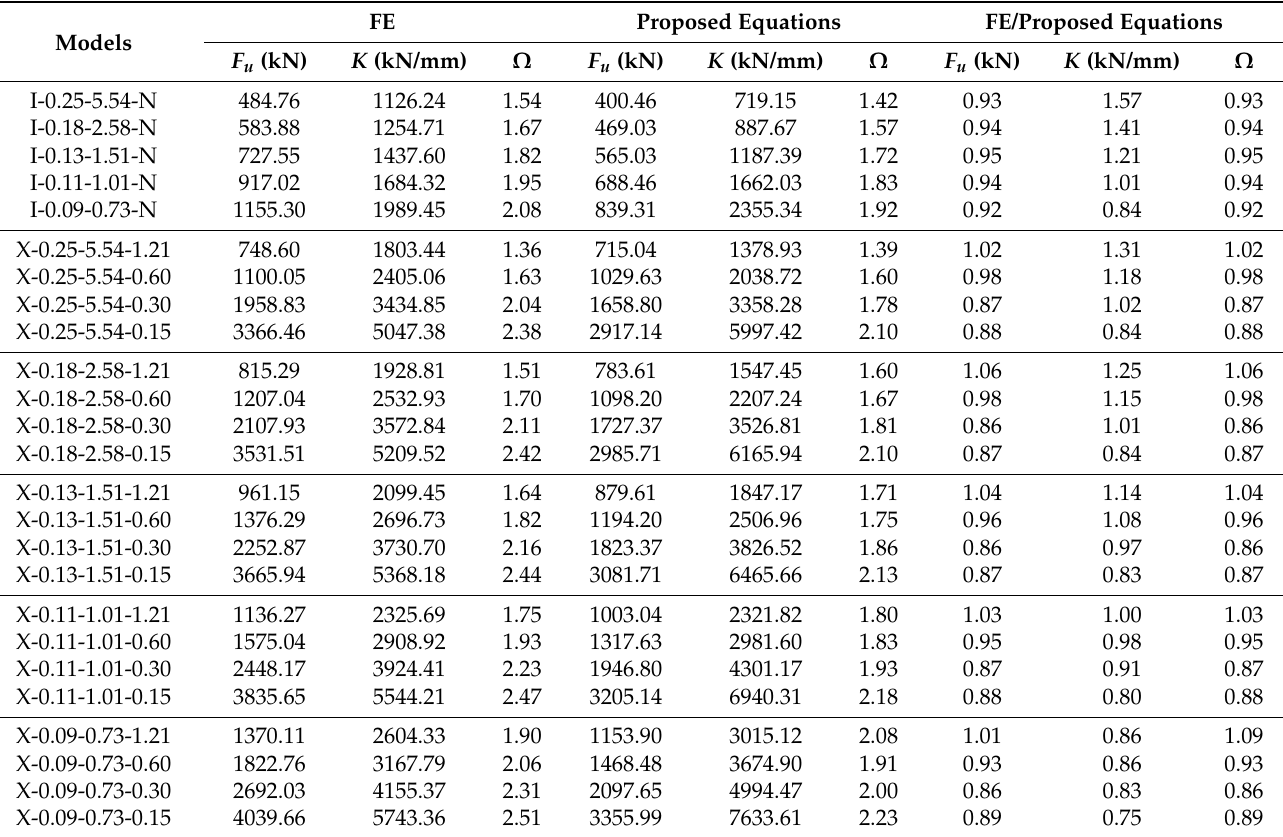
Table 4. Comparing results from proposed equations with